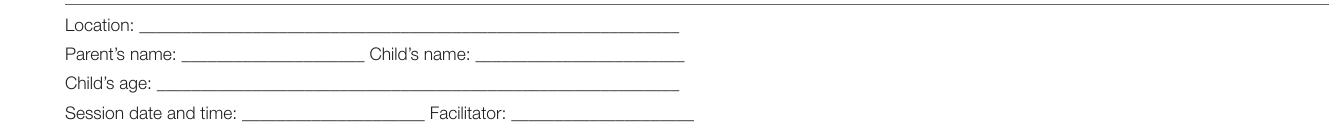
TABLE 3 | ATTACH TM fidelity checklist for dyadic